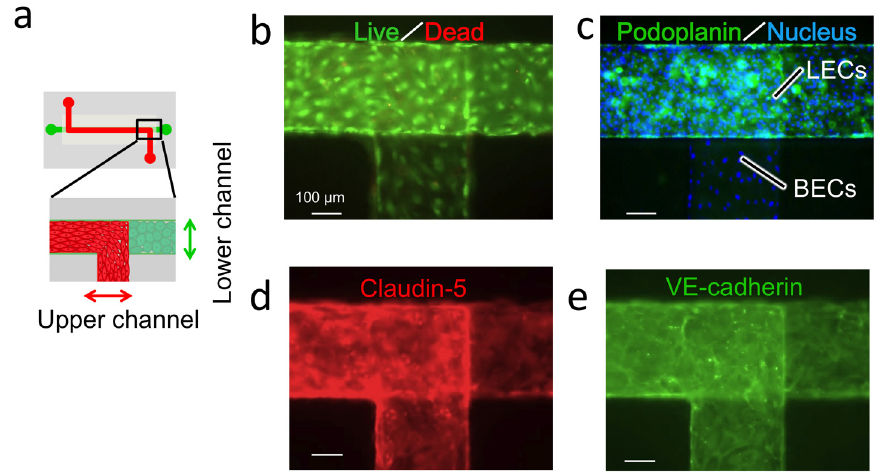
Fig 2. Characterization of BECs and LECs cocultured in the microfluidic device. (a) Schematic of the microfluidic device. The cells in red are BECs and the cells in green are LECs. (b) Live/dead analysis. (c) Detection of the lymphatic endothelium by immunostaining for a lymphatic marker, podoplanin. (d) Detection of an endothelial-specific protein, claudin-5, by immunostaining. (e) Detection of an endothelial-specific adhesion molecule, VE-cadherin, by immunostaining.